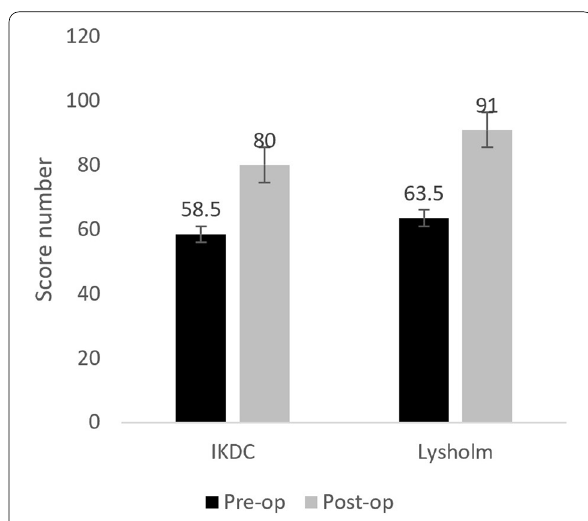
Fig. 4 Pre- and postoperative clinical